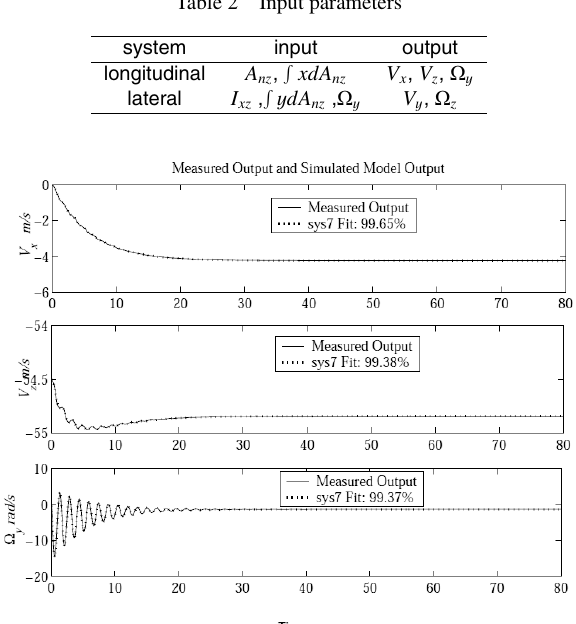
Fig. 3 Output from the simulation